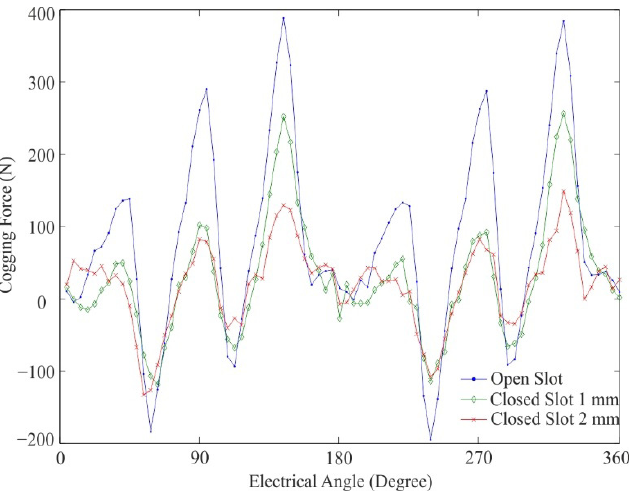
Figure 6. Cogging force over one pole pair during 360 electrical degree for open slot (dot), closed slot 1 mm thick (diamond) and closed slot 2 mm thick